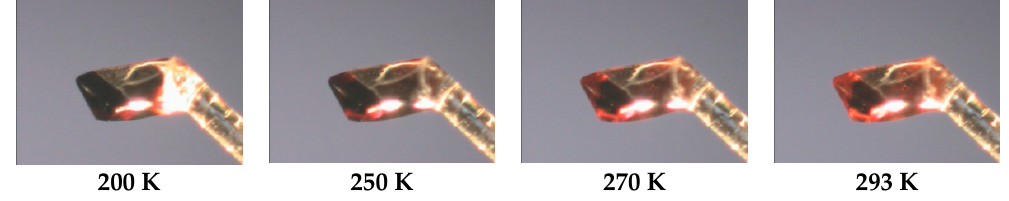
Figure 3. (Color on-line) Representation of the thermochromism of compound 2 . Table 1. Crystal structure parameters for compounds ( 1 ) and ( 2 ).